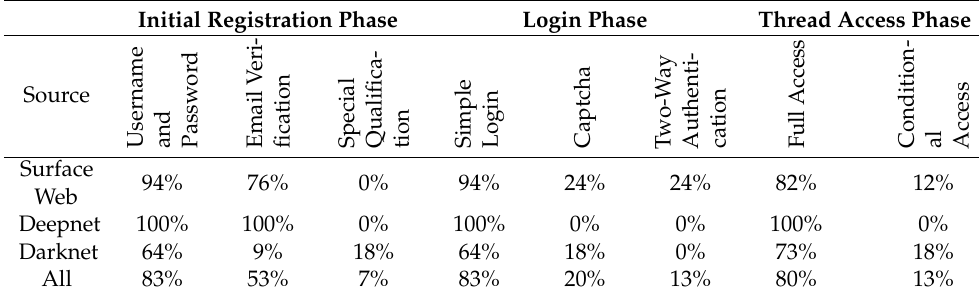
Table 1. Discussion Forums’